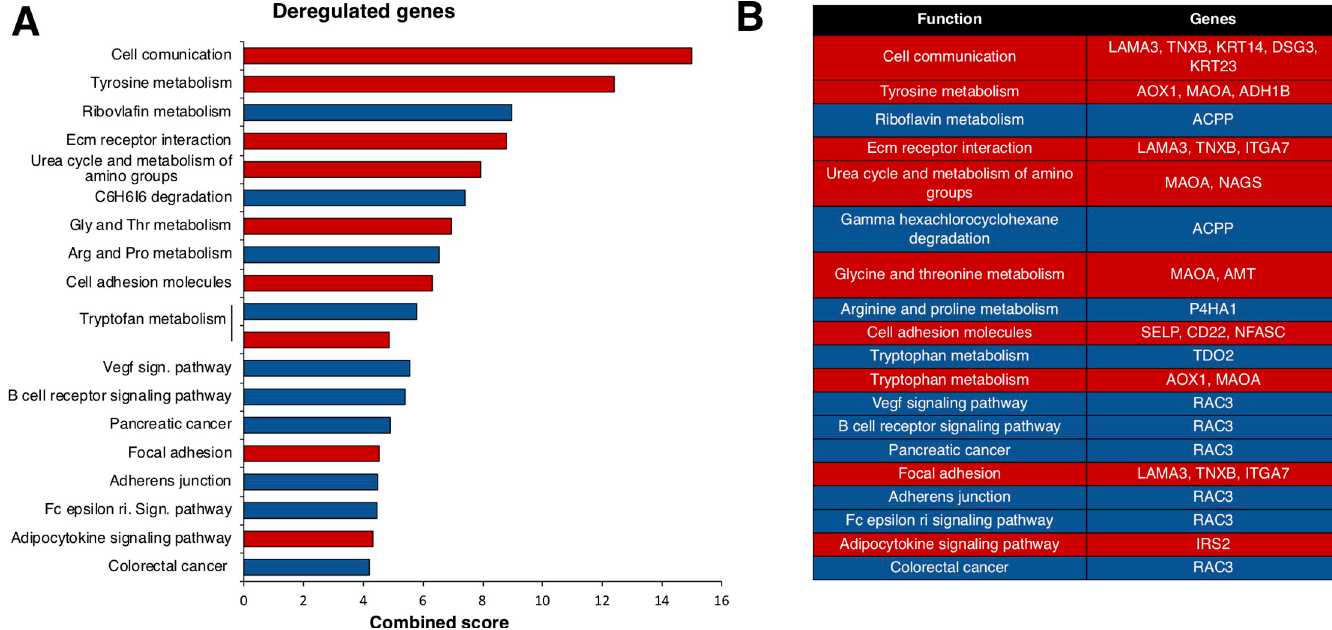
Fig 4. Functional analysis of deregulated genes included in the KMT2D mutated signature. A. Percentage of deregulated genes included in the KMT2D mutated signature by biological function. Overexpressed genes are displayed in blue and down-expressed genes in red. For functional annotation analysis, the online tool Enrichr was used as described in material and methods. B. Deregulated genes included in each function.